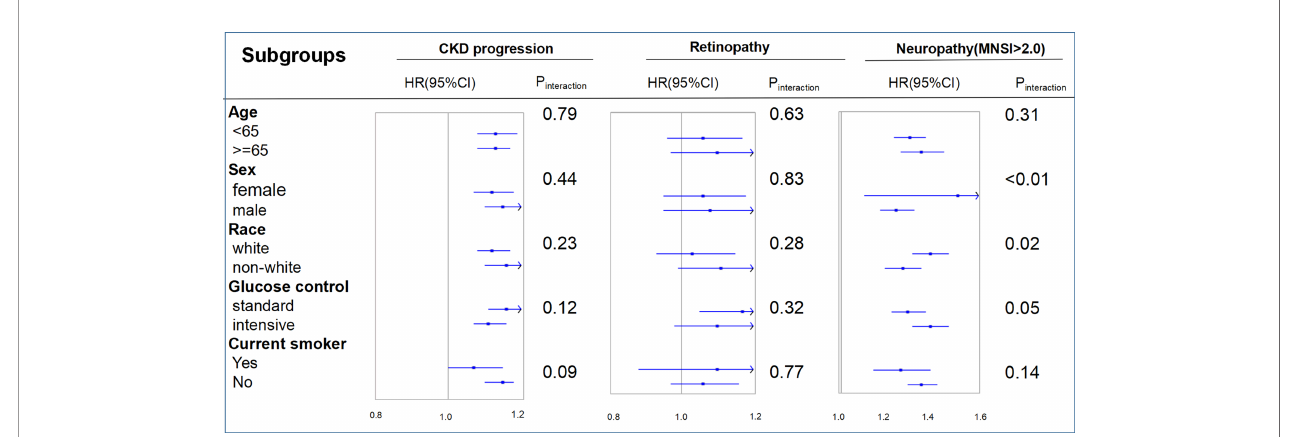
FIGURE 3 | Hazard ratios per one standard deviation increase in the fat mass index for the primary endpoints. Each strati fi cation was adjusted for all factors in model 3 (age, race, sex, treatment effect, diabetes duration, proteinuria, current smoking, weekly alcohol consumption, height, glomerular fi ltration rate, total cholesterol, low-density lipoprotein cholesterol, high-density lipoprotein cholesterol, systolic blood pressure, and hemoglobin A1C), except for the strati fi cation factor itself. CKD, chronic kidney disease; FMI, fat mass index; MNSI, Michigan Neuropathy Screening Instrument.